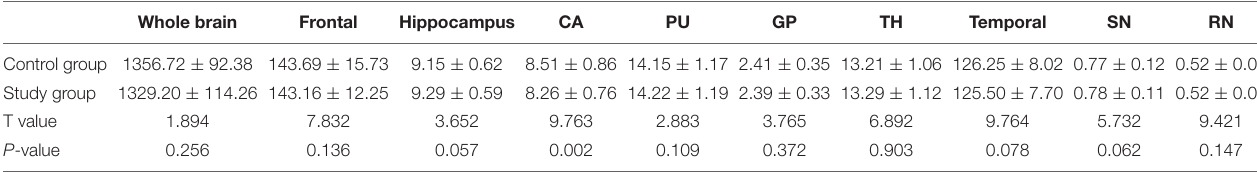
TABLE 3 | Comparison of the brain volume measurement data between the study and control groups [cm 3 , x ± s, n = 60]. Whole brain Frontal Hippocampus CA PU GP TH Temporal SN RN